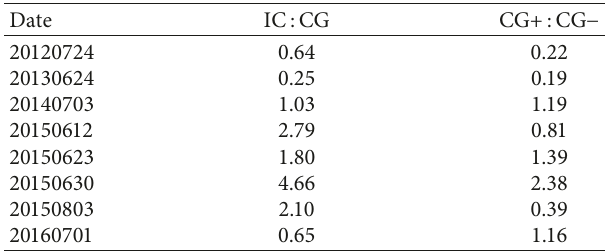
Table 6: Summary of IC :CG and CG+:CG − ratios for null severe wind